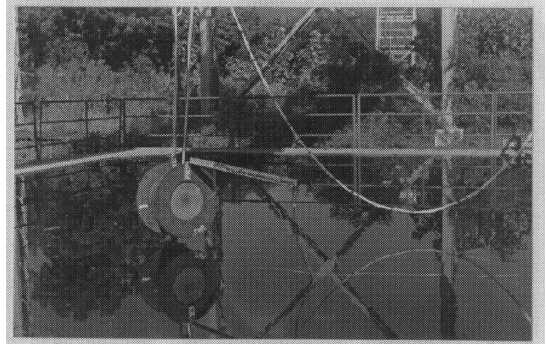
Fig. 3. Photographic view of the test assembly used for the dynamic strain